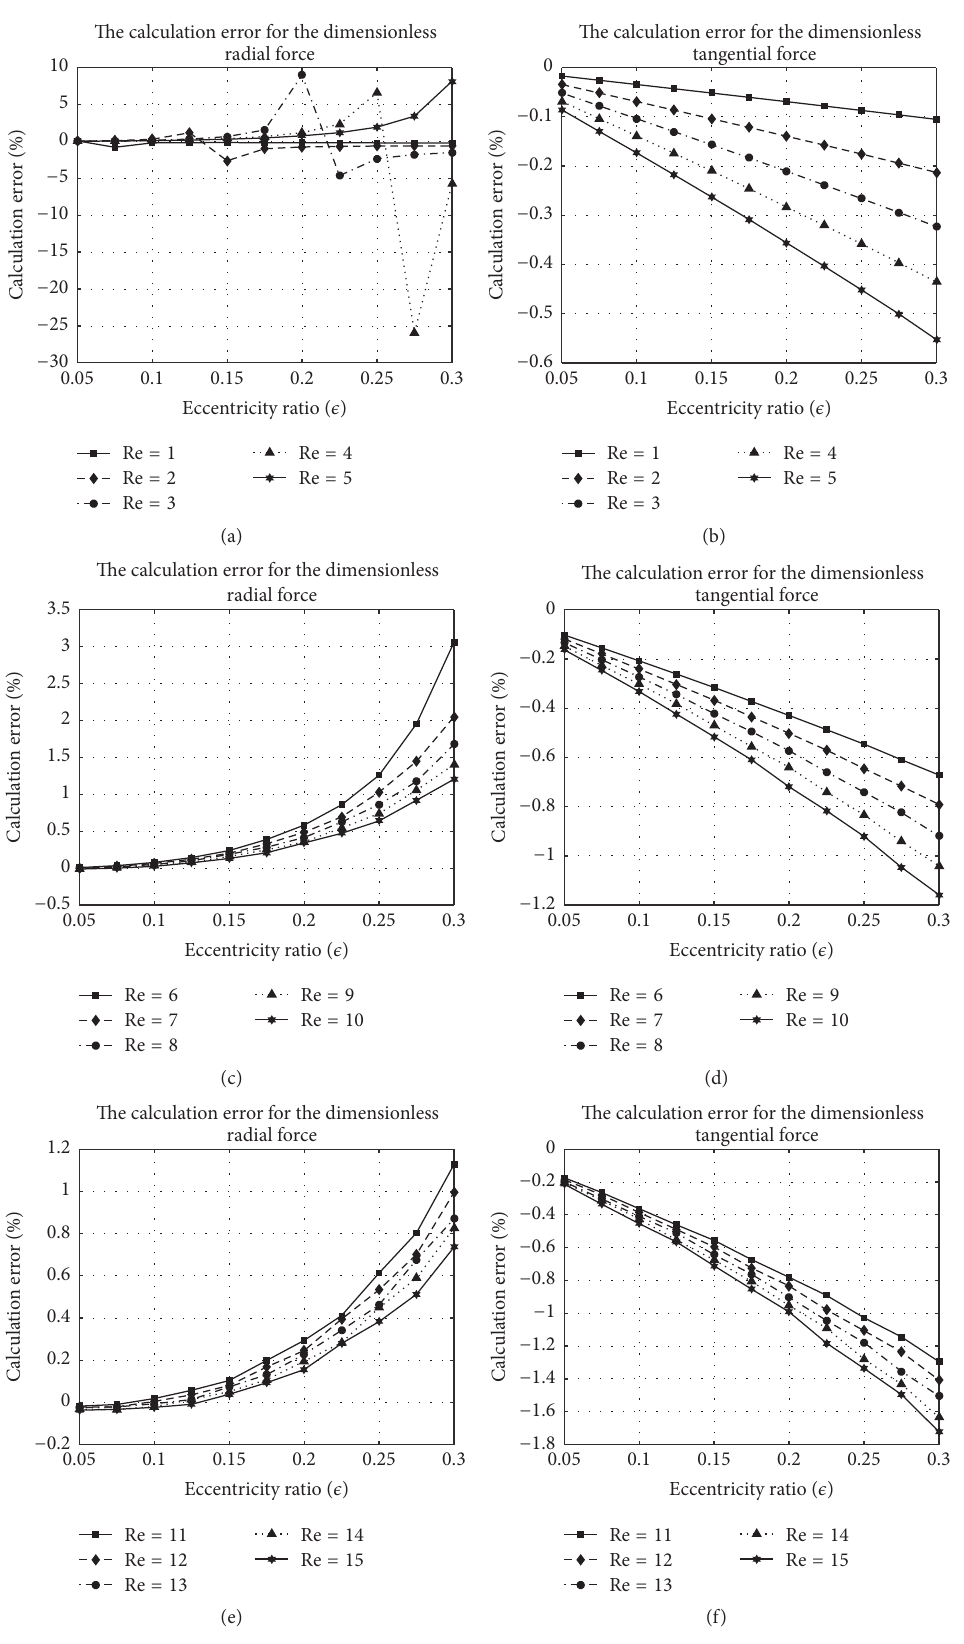
Figure 8: Contribution of the third-order nonlinear term in the pressure model to the dimensionless force